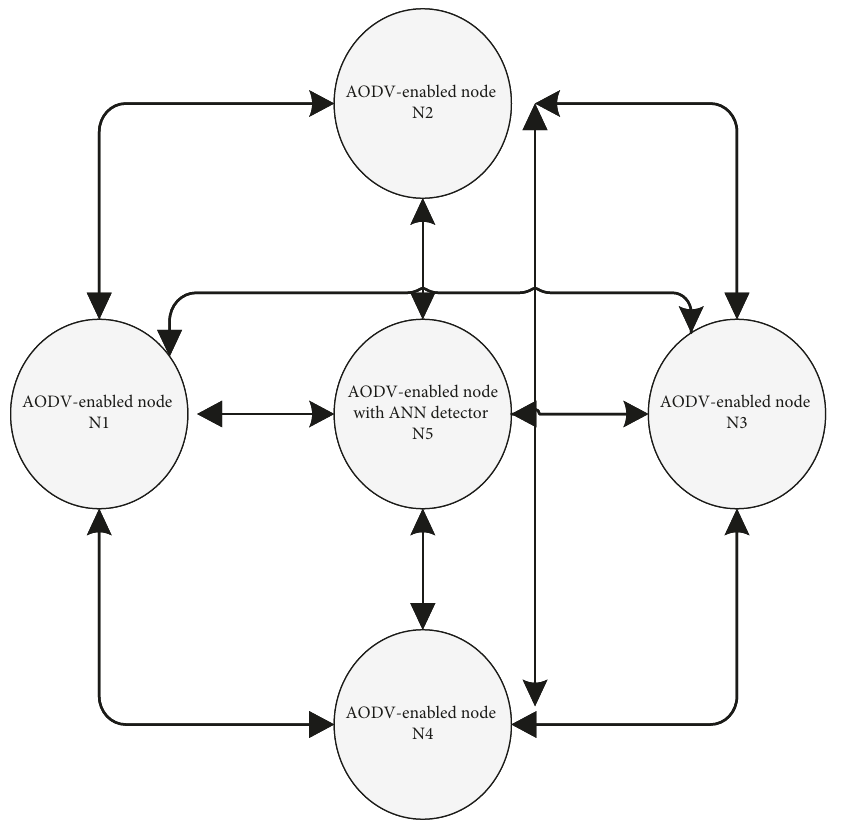
Figure 1: General system architecture of the new working